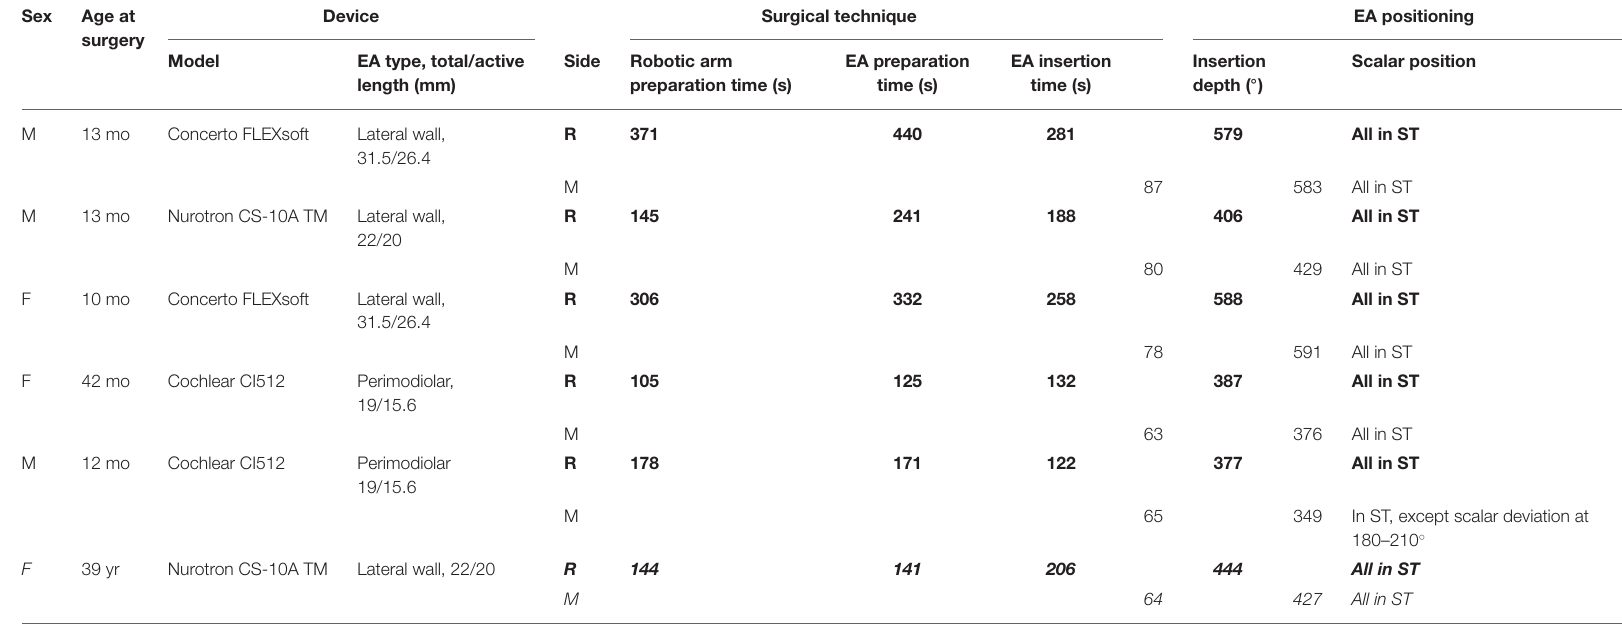
TABLE 1 | Cochlear implant type and surgical outcomes in the six cases in this study.